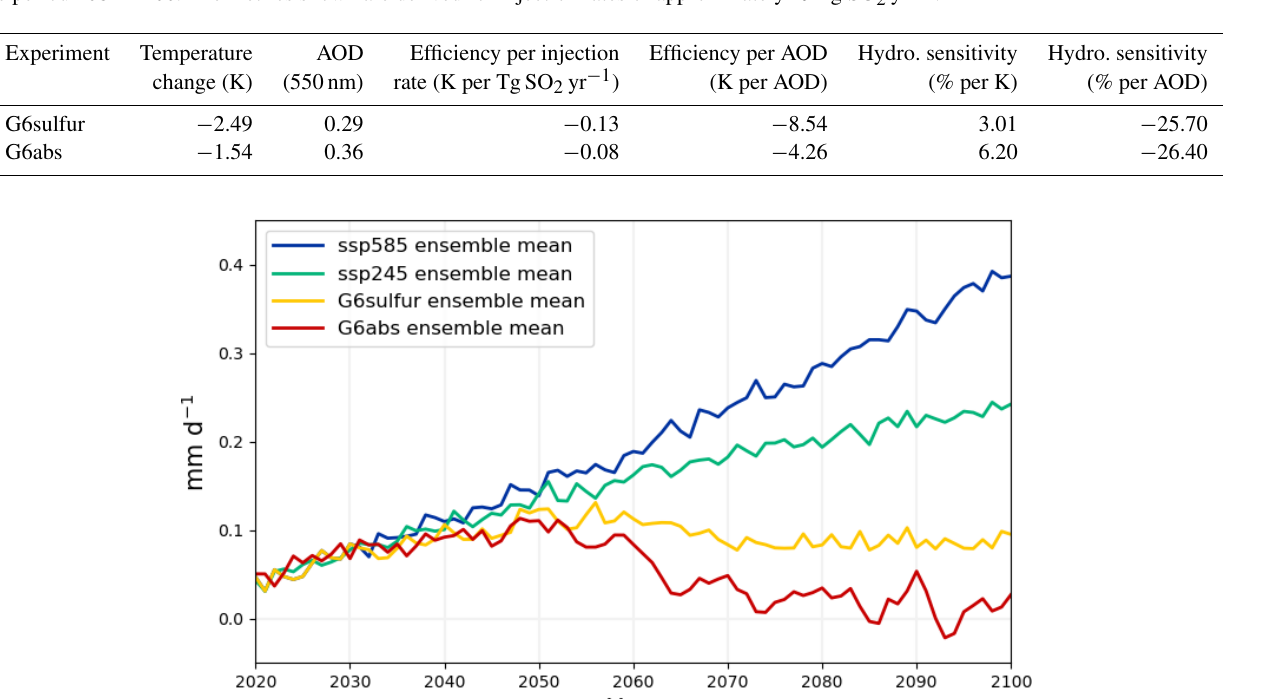
Table 1. Summarising the global-mean cooling efficiency and hydrological sensitivity for G6sulfur and G6abs compared to SSP5–8.5 over the period 2081–2100. The metrics shown are derived for injection rates of approximately 19Tg SO 2 yr − 1 .